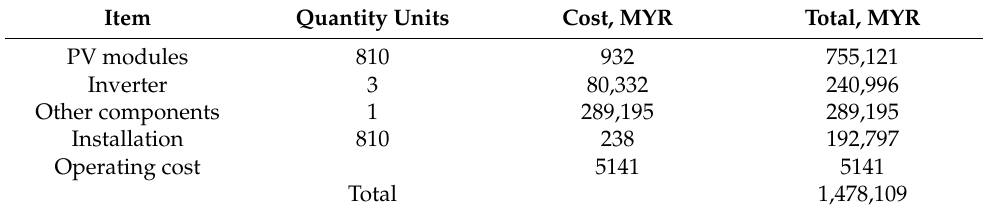
Table 8. Cost details of the PV system components.